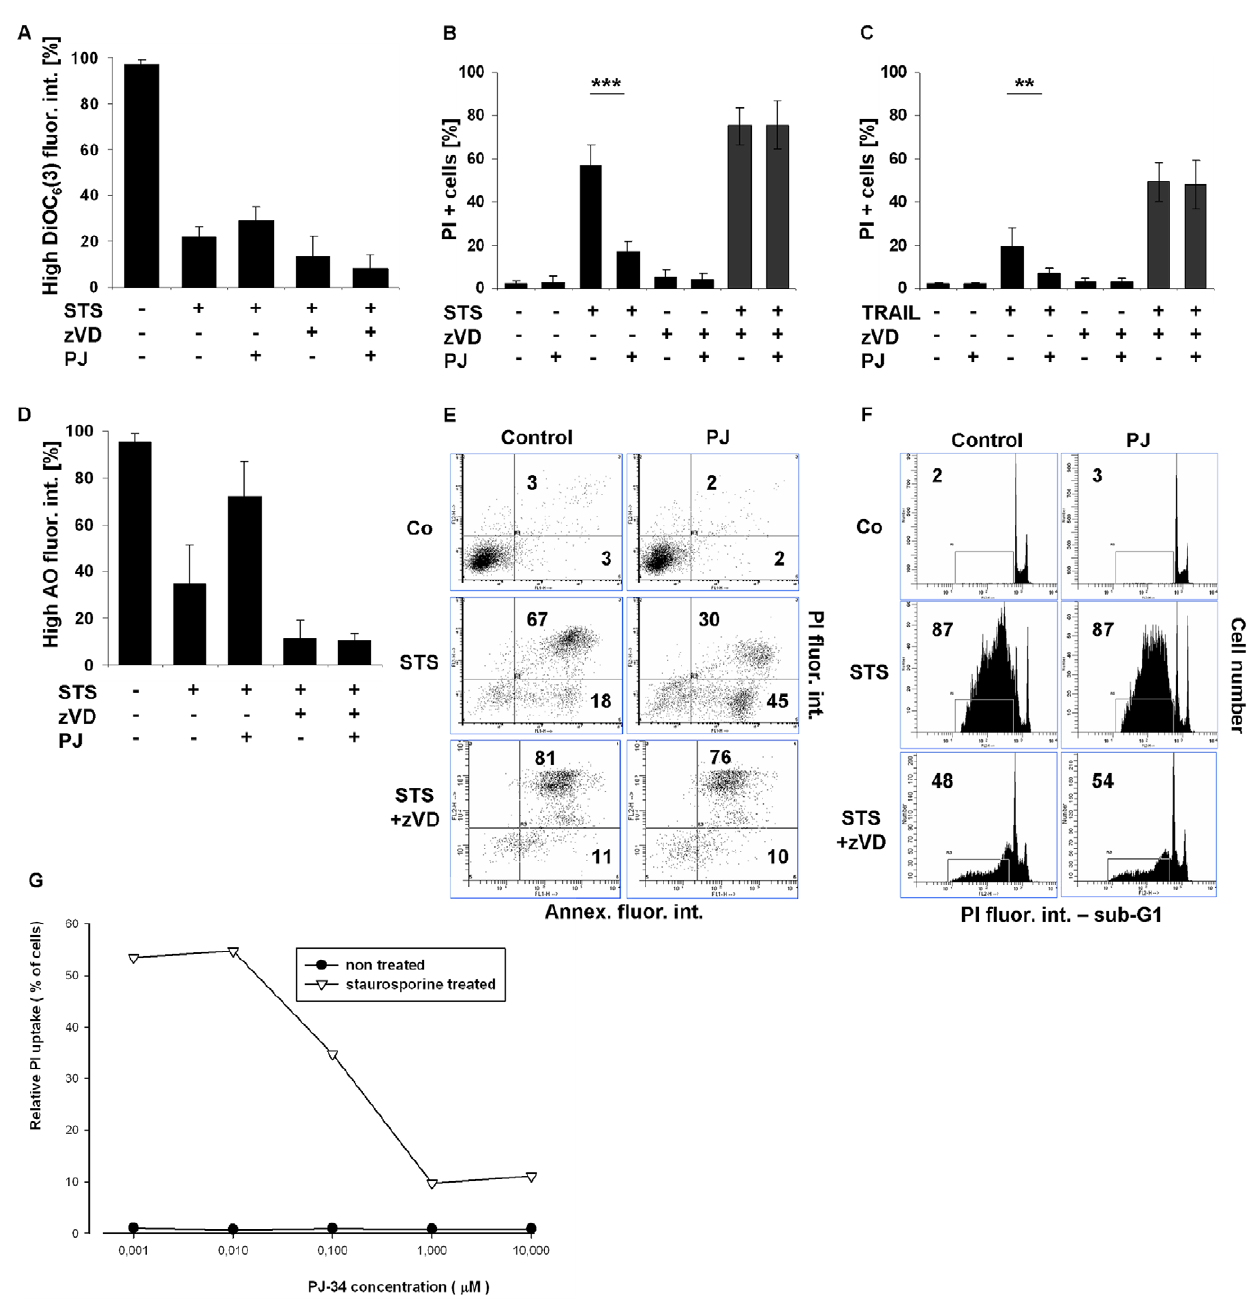
Figure 5. PJ3-4 does not arrest either the TRAIL or STS-induced necroptosis in presence of caspase inhibitor. U937 cells were treated either with STS (1 m M) or with TRAIL (50 ng/mL) in the presence or absence of zVD (5 m M) for 20 hrs. PJ-34 (1 m M) was added 1 hr before cell death was induced. (A) Column diagram of percentage of cells with high DiOC 6 (3) fluorescence intensity (n=3). (B-C) PJ-34 (1 m M) considerably inhibited the (B) STS (n=8) or (C) TRAIL-triggered (n=8) secondary necrosis but not the necroptosis. Percentage of PI positive cells was determined. Values are mean 6 SD. *, P , 0.05, **, P , 0.01 and ***, P , 0.001 calculated by Student’s t-probe. (D) Column diagram of percentage of cells with high AO fluorescence intensity (n=2). (E) Dot plot distribution of cells stained with Annexin V-FITC and PI analyzed by flow cytometry. The values indicate the percentage of cells in the marked regions (representative of n=2). (F) Representative histograms of distribution of PI stained, ethanol-fixed (sub-G1) cells were analyzed by flow cytometry (n=8). The numbers indicate the percentage of cells in the marked regions. (G) PJ-34 concentration dependently reduced the proportion of PI positive cells for STS treatment for 20 hrs – representative experiment. doi:10.1371/journal.pone.0041945.g005 inhibition while NSA results in full protection we propose the How STS induces necroptosis is rather enigmatic. Death hypothesis that STS acts through two parallel pathways which are receptor-independent assembly of Ripoptosome is a recently equally dependent on MLKL. proposed model [24]. This process is controlled by endogenous inhibitors of apoptosis proteins (cIAPs) and the X-linked inhibitor